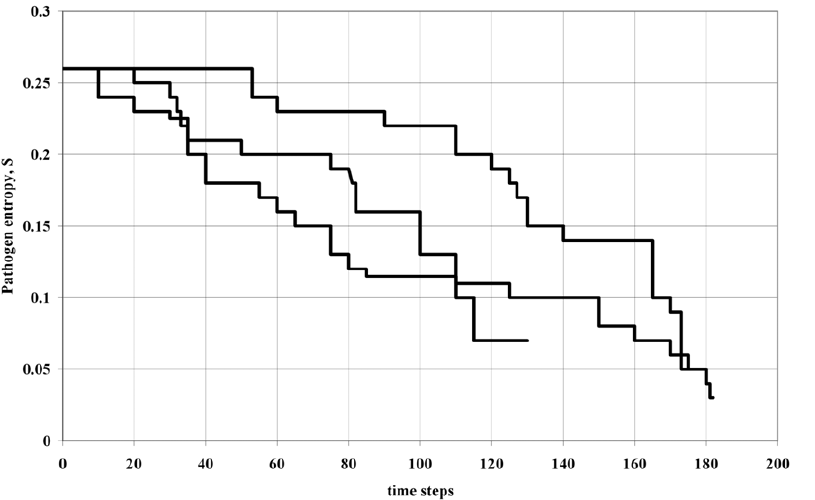
Figure 1. Simulation showing evolutionary entropy of dominant variant decreasing over time for three realisations of the simulation (arbitrary units). This corresponds to the scenario of W w 0 , i.e. variants are competing against incumbents with positive growth rates in the host population. Because D H D S w 0 , a plot of H versus time would yield the same pattern.